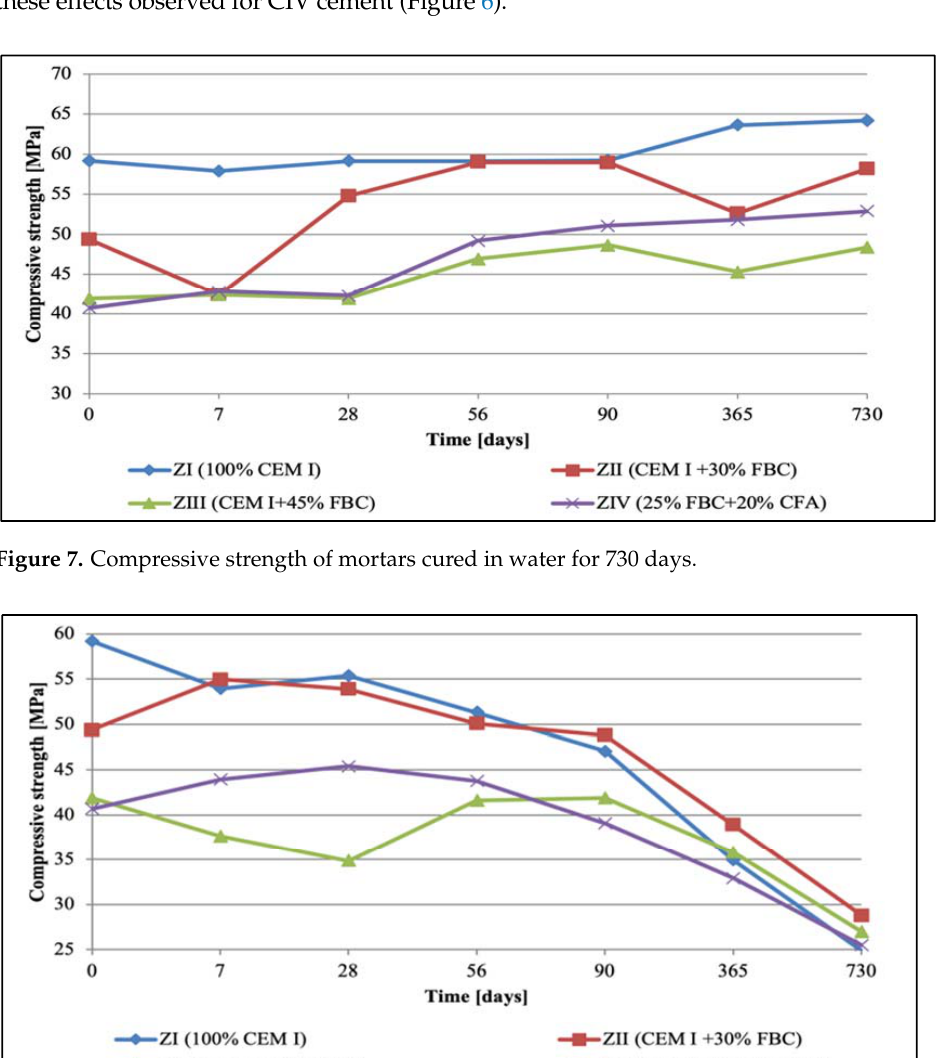
Figure 8. Compressive strength of mortars cured for 730 days in 1% solution of hydrochloric acid with pH = 2. The analysis of data presented in Figure 9 shows that up to 56 days of curing in the aggressive environment, the mortars’ strengths stayed more or less at the same level, whereas the highest drop in their strength was observed between the 90th and 365th day